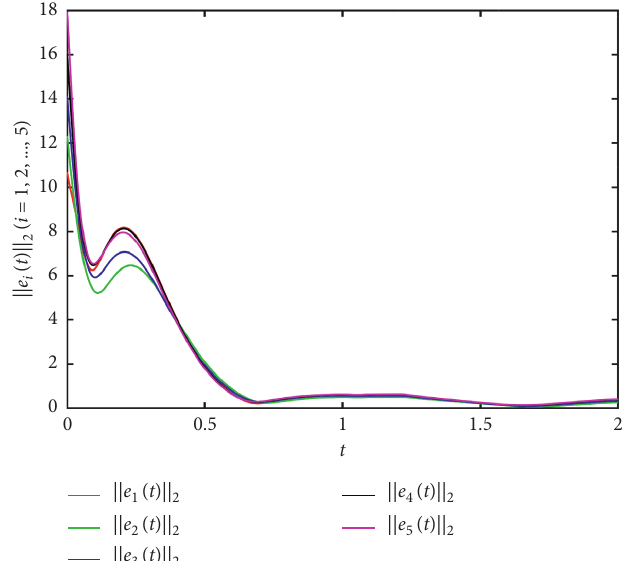
Figure 4: The changes of ‖ e